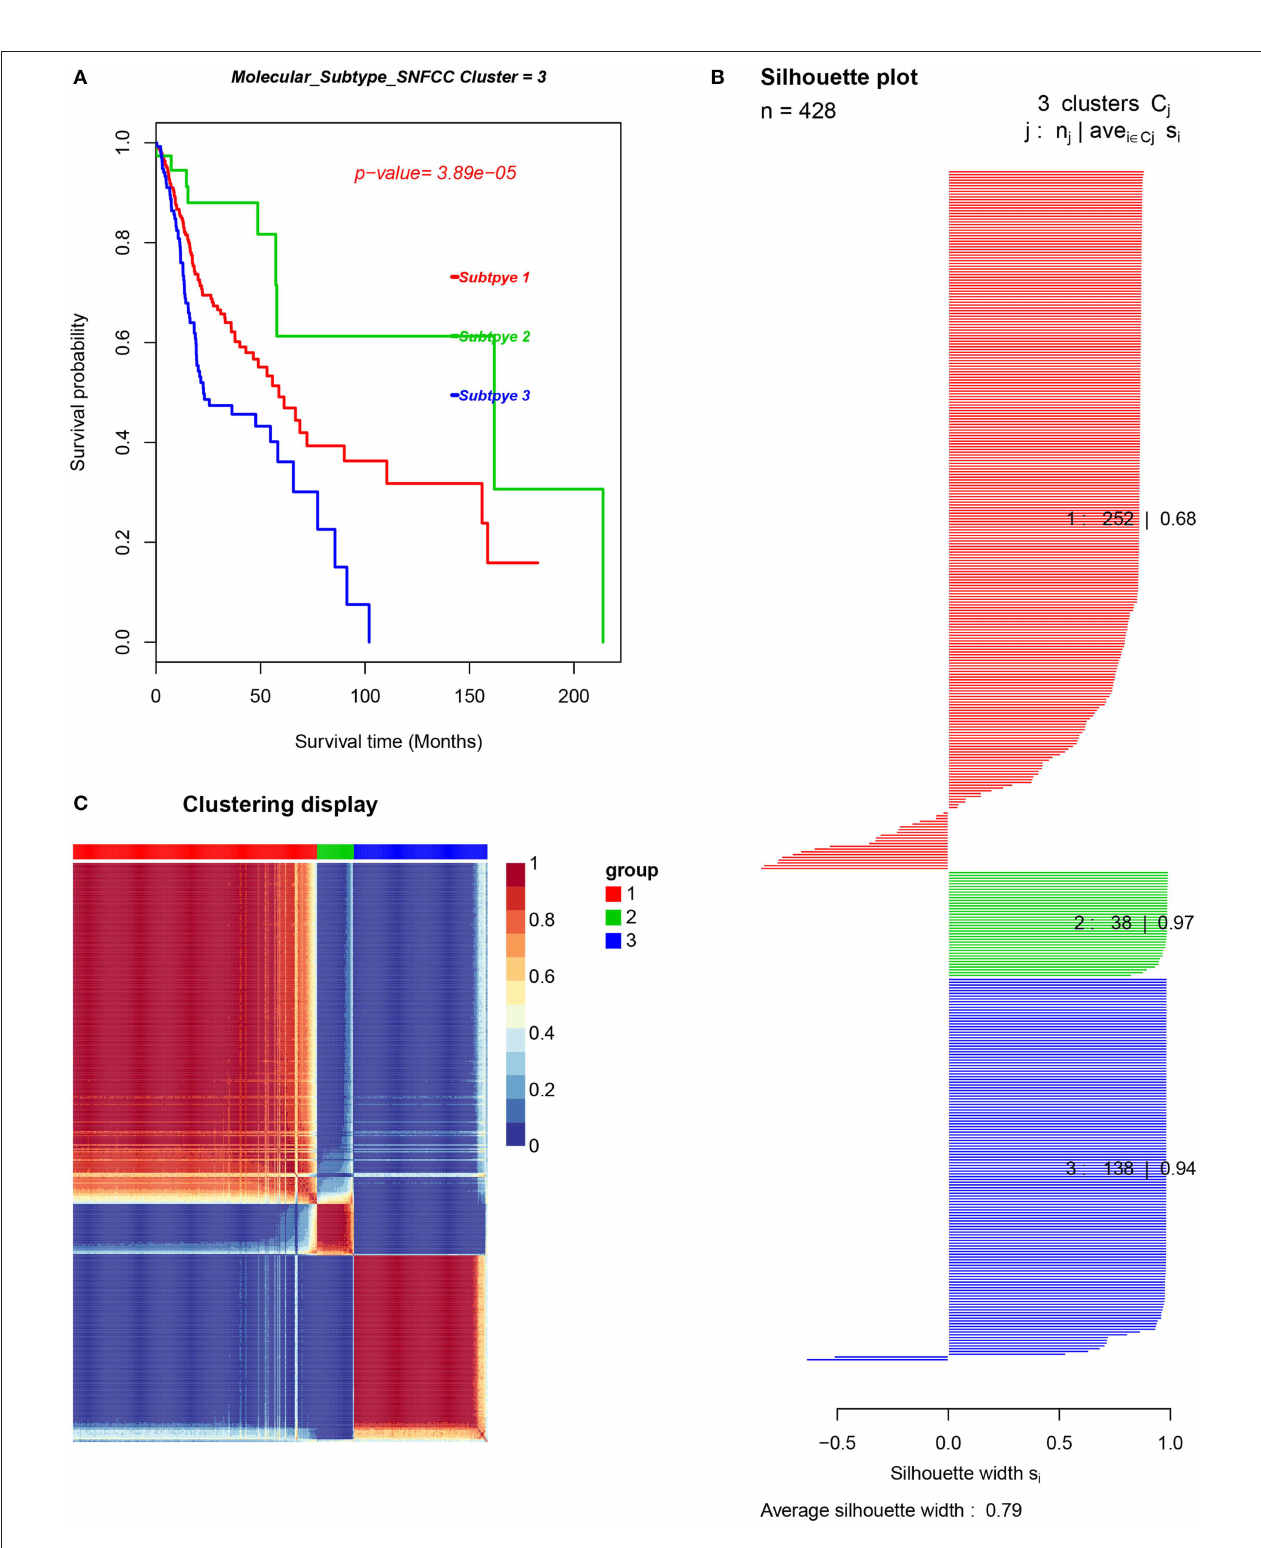
FIGURE 12 | The cancer subtypes using SNFCC + algorithm. (A) Log-rank test p -value for Kaplan–Meier survival analysis, (B) clustering heatmap visualizing the degree of the partitioning of the sample clusters, (C) average silhouette width representing the coherence of clusters.